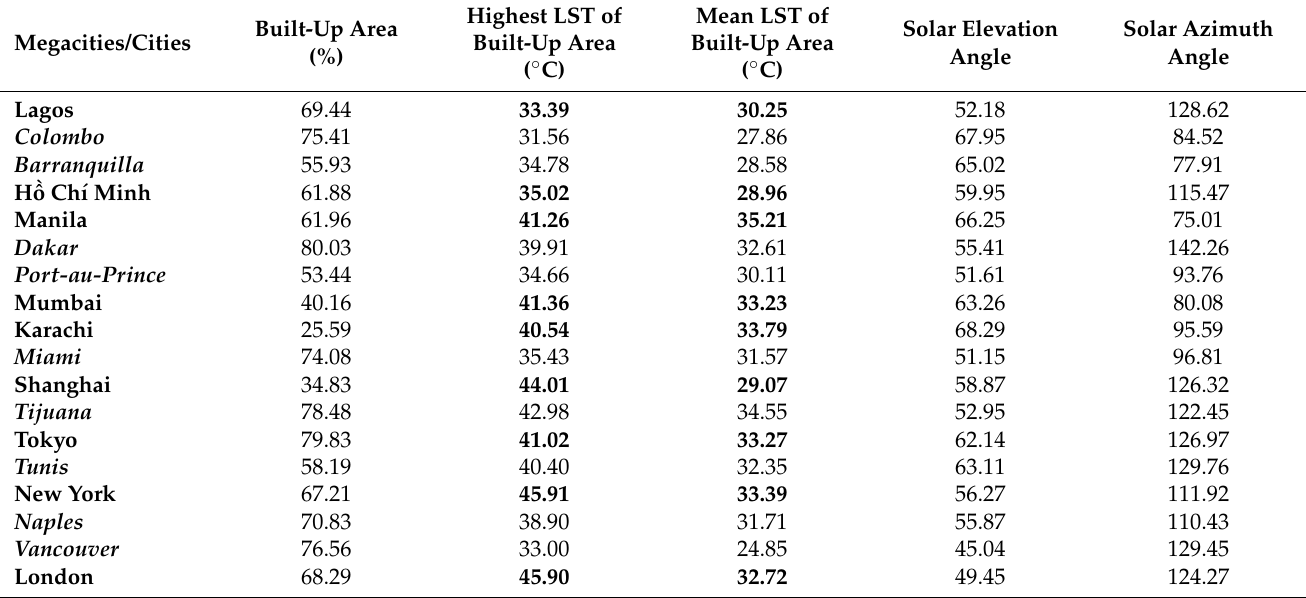
Table 3. Built-up area percentage, highest and mean LST, and elevation and azimuth sun angles for cities and